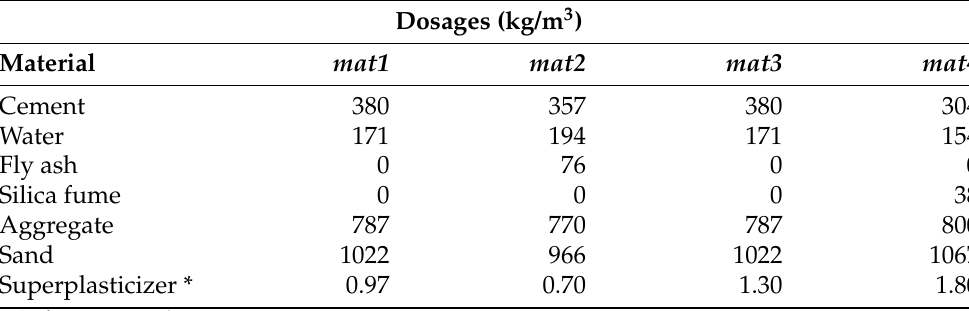
Table 1. Dosages of the studied materials.